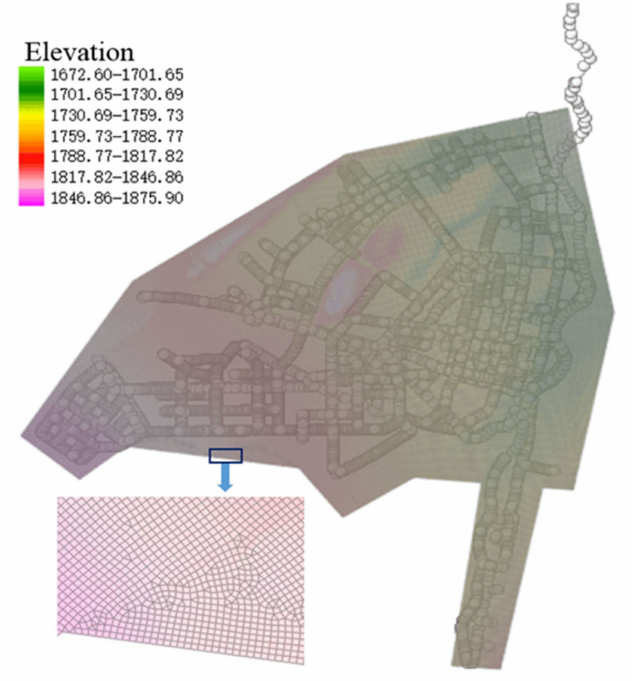
Figure 5. The coupled 1D and 2D hydrodynamic model of the study